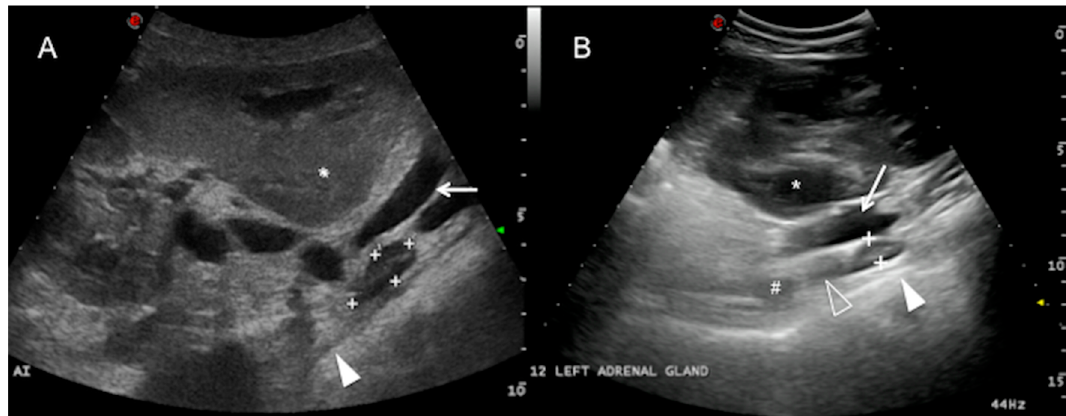
Figure 3. Left adrenal gland. Dorsal plane from the right paralumbar abdomen ( A ) and 12th intercostal space (ICS) ( B ) of two different cows, showing the left adrenal gland (between cursors or “+” sign) adjacent to the aorta (not visible in this plane) and the caudal vena cava (white arrow), medial to the right kidney (asterisk). Note that the gland is in close contact with the dorsal sac of the rumen (white solid arrowhead) and caudal to the coeliac artery (#) and the cranial mesenteric artery (white hollow arrowhead). The adrenal cortex and medulla can be differentiated. Cranial is to the left of the image. AI = left adrenal gland.